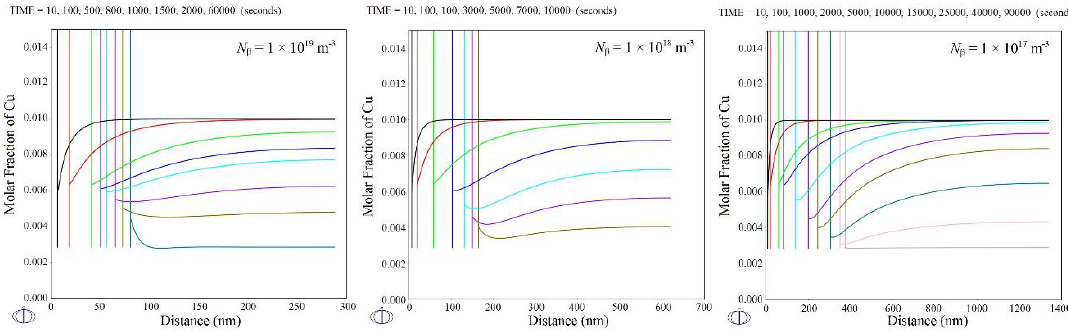
Figure 9. Solute concentration profiles in front of the spherical θ -Al 2 Cu as calculated by DICTRA at different times for systems having different values for the number density.